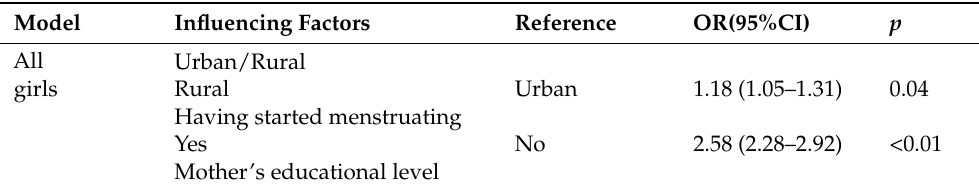
Table 2. Factors associated with adolescent girls’ anemia based on multivariate logistic regres- sion